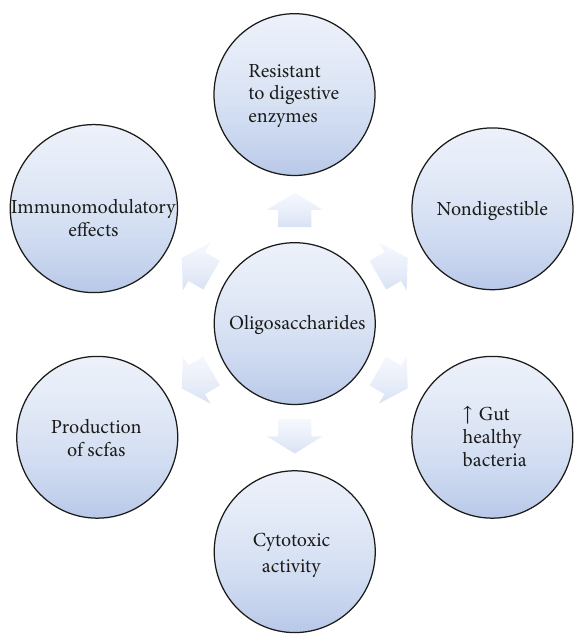
Figure 5: Effects of